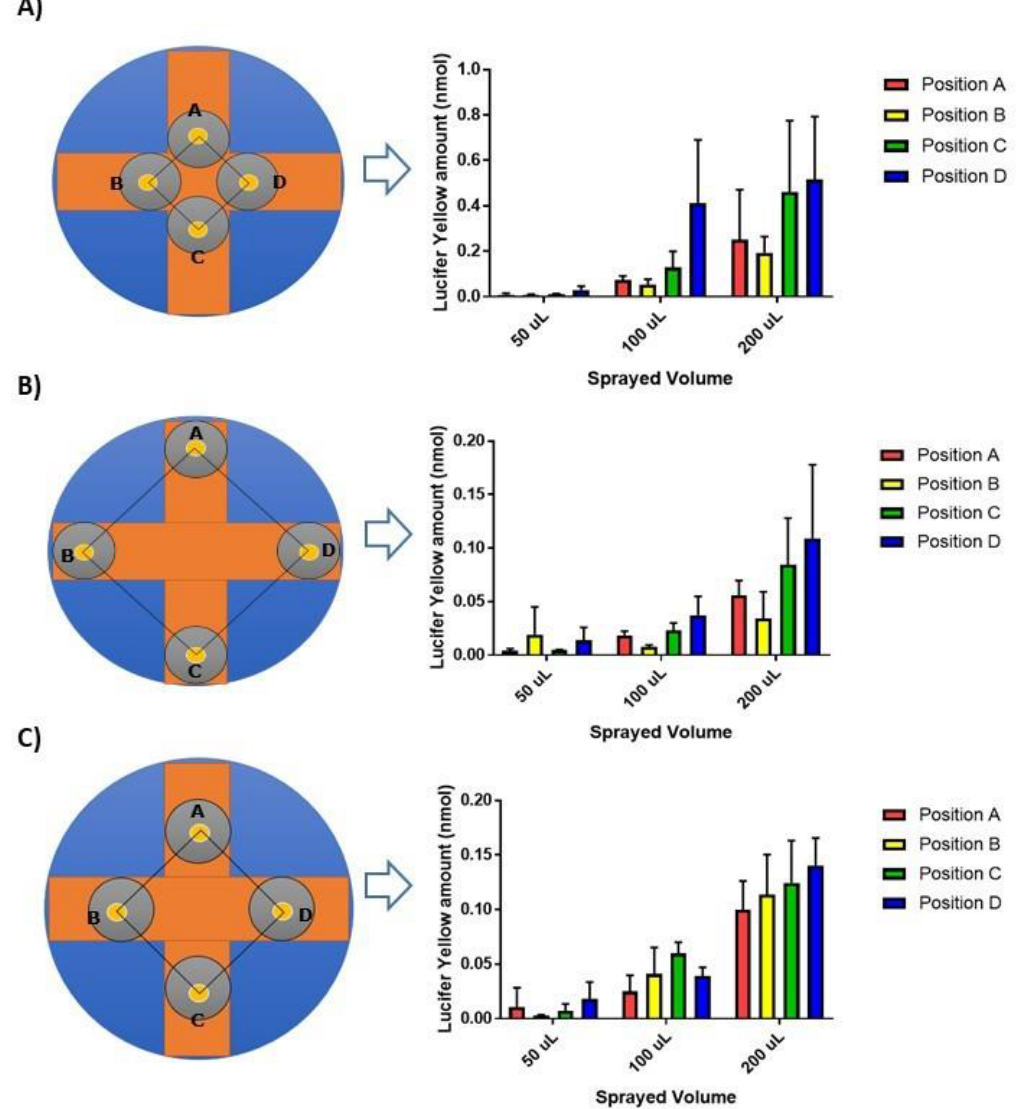
Figure 3. Doses of Lucifer yellow deposited on Transwell ® inserts when sprayed from a distance of 20 cm. Inserts were arranged to cover a 20 ( A ), 100 ( B ), or 50 ( C ) cm 2 surface area. Data are presented as mean ± SD (n = 3).